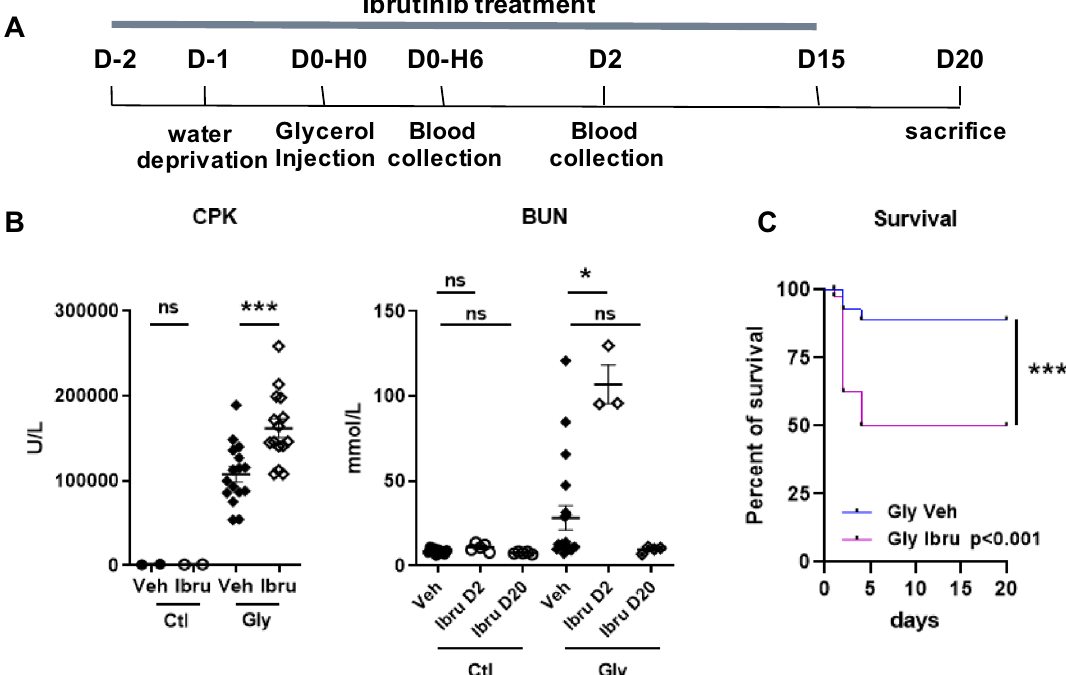
Figure 2. Prophylactic treatment with ibrutinib exacerbates rhabdomyolysis with subsequent severer acute kidney injury and higher mortality. ( A ) Design of the study. ( B ) Plasma level of CPK (6 h) and BUN (day 2 (D2) and 20 (D20)) after glycerol injection. (Mann–Whitney test and ANOVA, Tukey’s test; n = 3–15 mice per group). ( C ) Kaplan–Meier survival curves after glycerol injection in mice receiving ibrutinib (Ibru) or vehicle (Veh). Kaplan–Meier curves significance was calculated according to the Log-rank test. Values are expressed as mean ± SEM. *p < 0.05, ***p < 0.001, compared with the vehicle group; ns, not